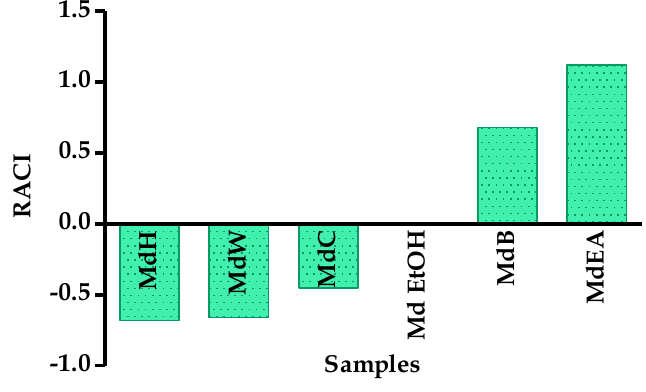
Figure 3. Relative Antioxidant Capacity Index (RACI) of different M. diffusa samples.